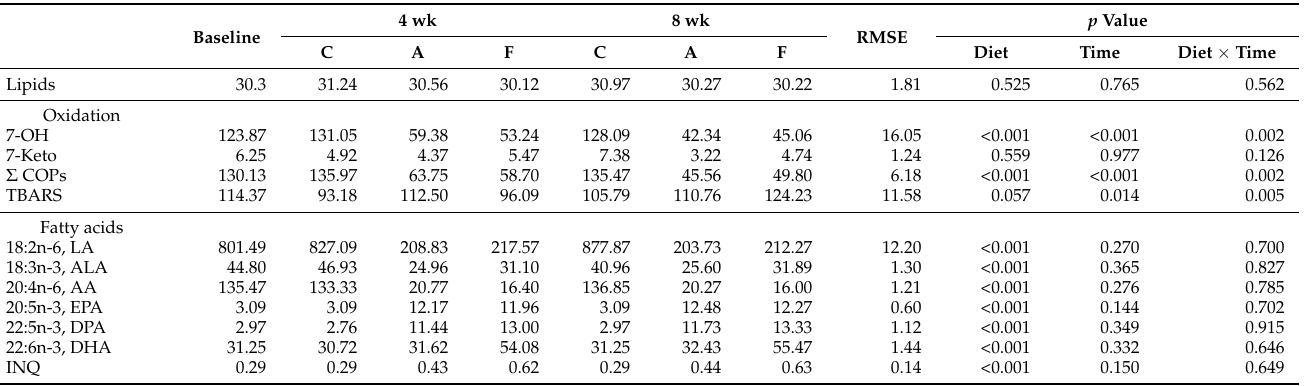
Table 4. Yolk lipid (%) content, cholesterol-oxidized products (COPs, µ g/100 g egg), lipid oxidation